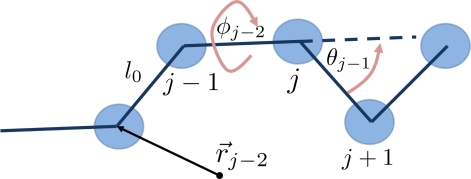
Illustration of the potential parameters used for modeling bonded interactions.